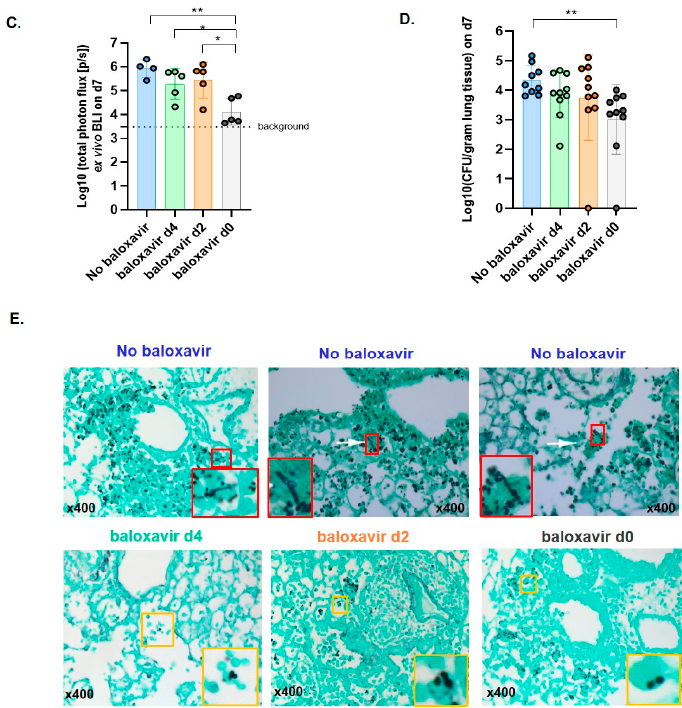
Figure 4. Baloxavir marboxil is effective in preventing secondary invasive pulmonary aspergillosis. ( A ) Bioluminescence images (BLI) of one mouse per group acquired on day 5, day 6 and day 7 post influenza-infection. ( B ) Quantification of total photon flux from in vivo BLI based on ROI covering the complete lung region and represented as the % change of the log 10 (total photon flux) values in comparison with baseline of influenza- Aspergillus day 4 co-infected mice without baloxavir marboxil (blue, n = 5 mice), baloxavir marboxil from day 4 (green, n = 5 mice), baloxavir marboxil from day 2 (orange, n = 5 mice) and baloxavir marboxil from day 0 (grey, n = 5 mice). Longitudinal statistical analysis: repeated measurements two-way ANOVA with Tukey’s multiple comparisons test performed from day 4 until day 7. ( C ) Quantification of the total photon flux from ex vivo BL images based on ROI covering the well containing undiluted lung homogenates on day 7 from no baloxavir marboxil (sham, blue, n = 5 mice), baloxavir marboxil from day 4 (green, n = 5 mice), baloxavir marboxil from day 2 (orange, n = 5 mice) and baloxavir marboxil from day 0 (grey, n = 5 mice) treated mice. ( D ) Graph representing the log 10 CFU count per gram lung tissue on day 7 from non-treated (no baloxavir, blue, n = 10 mice), baloxavir marboxil from day 4 (green, n = 10 mice), baloxavir marboxil from day 2 (orange, n = 10 mice) and baloxavir marboxil from day 0 (grey, n = 10 mice). ( E ) Histological Grocott’s methenamine silver staining (GMS) (magnification × 400) of left lung of different groups (no baloxavir, baloxavir marboxil treatment from day 4, baloxavir marboxil treatment from day 2, baloxavir marboxil treatment from day 0) sacrificed on day 7. Hyphae (red box), intracellular conidia (yellow box). Differences were considered significant if p was smaller or equal to 0.05. * p < 0.05, ** p < 0.01, *** p < 0.001. Data are represented as mean ±